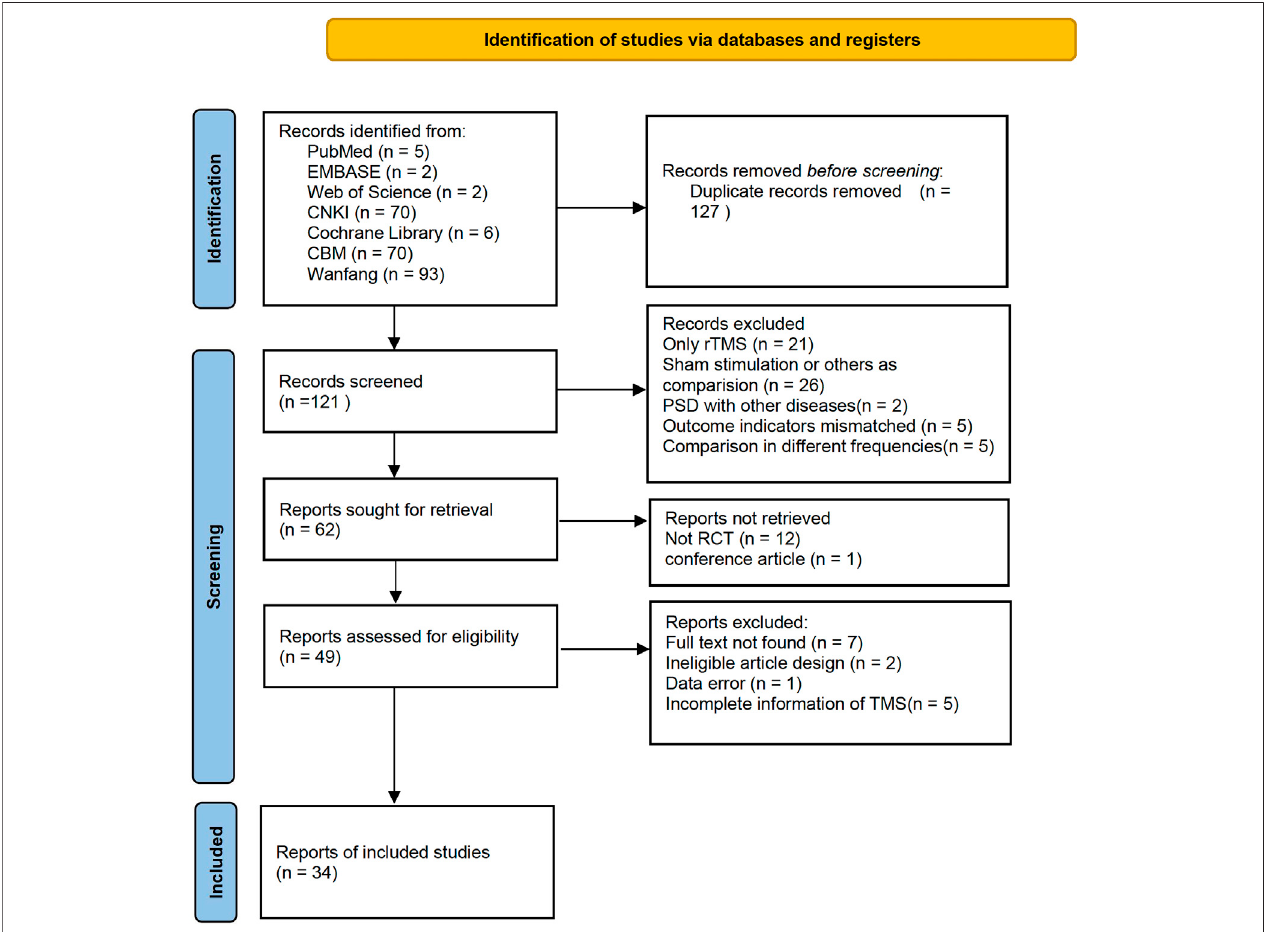
FIGURE 1 | Flow diagram of article